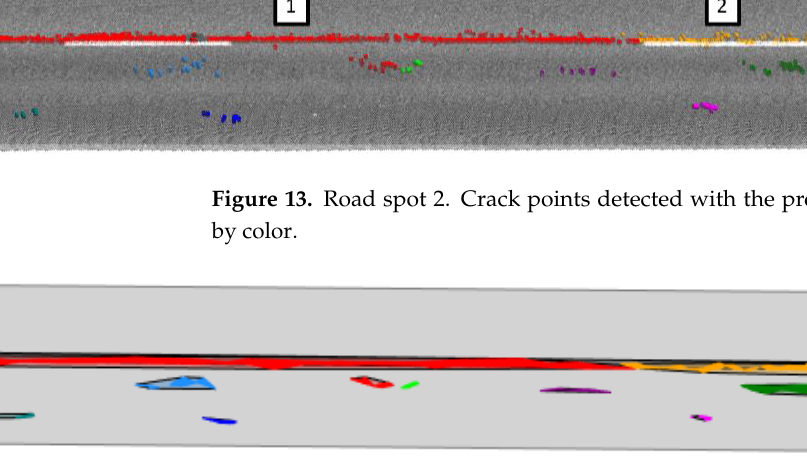
Figure 14. Road spot 2. Crack clusters detected with the proposed algorithm, delimited with both convex hulls ( light color ) and alpha-shapes ( intense color ). Boxes in grey delimit the manually segmented cracked areas.